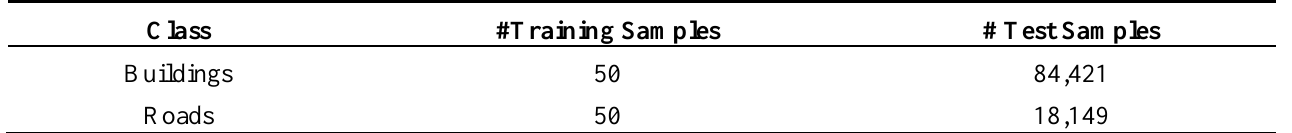
Table 4. Numbers of samples for the Pavia City